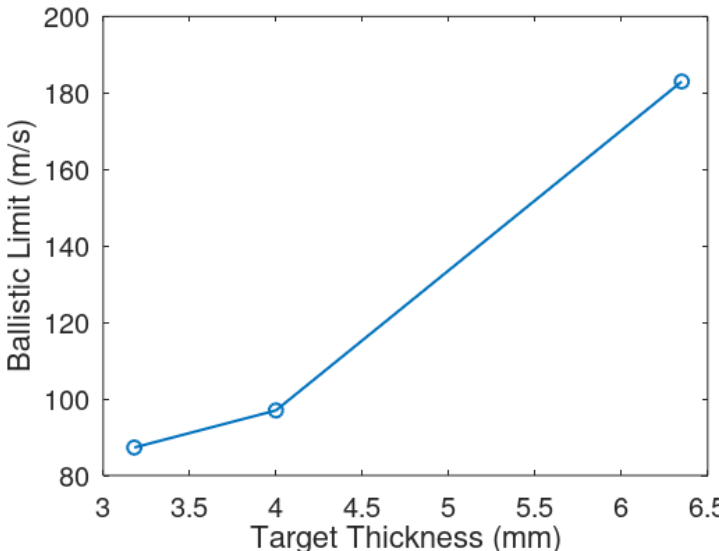
Figure 14. Variation in ballistic velocities with target thicknesses.